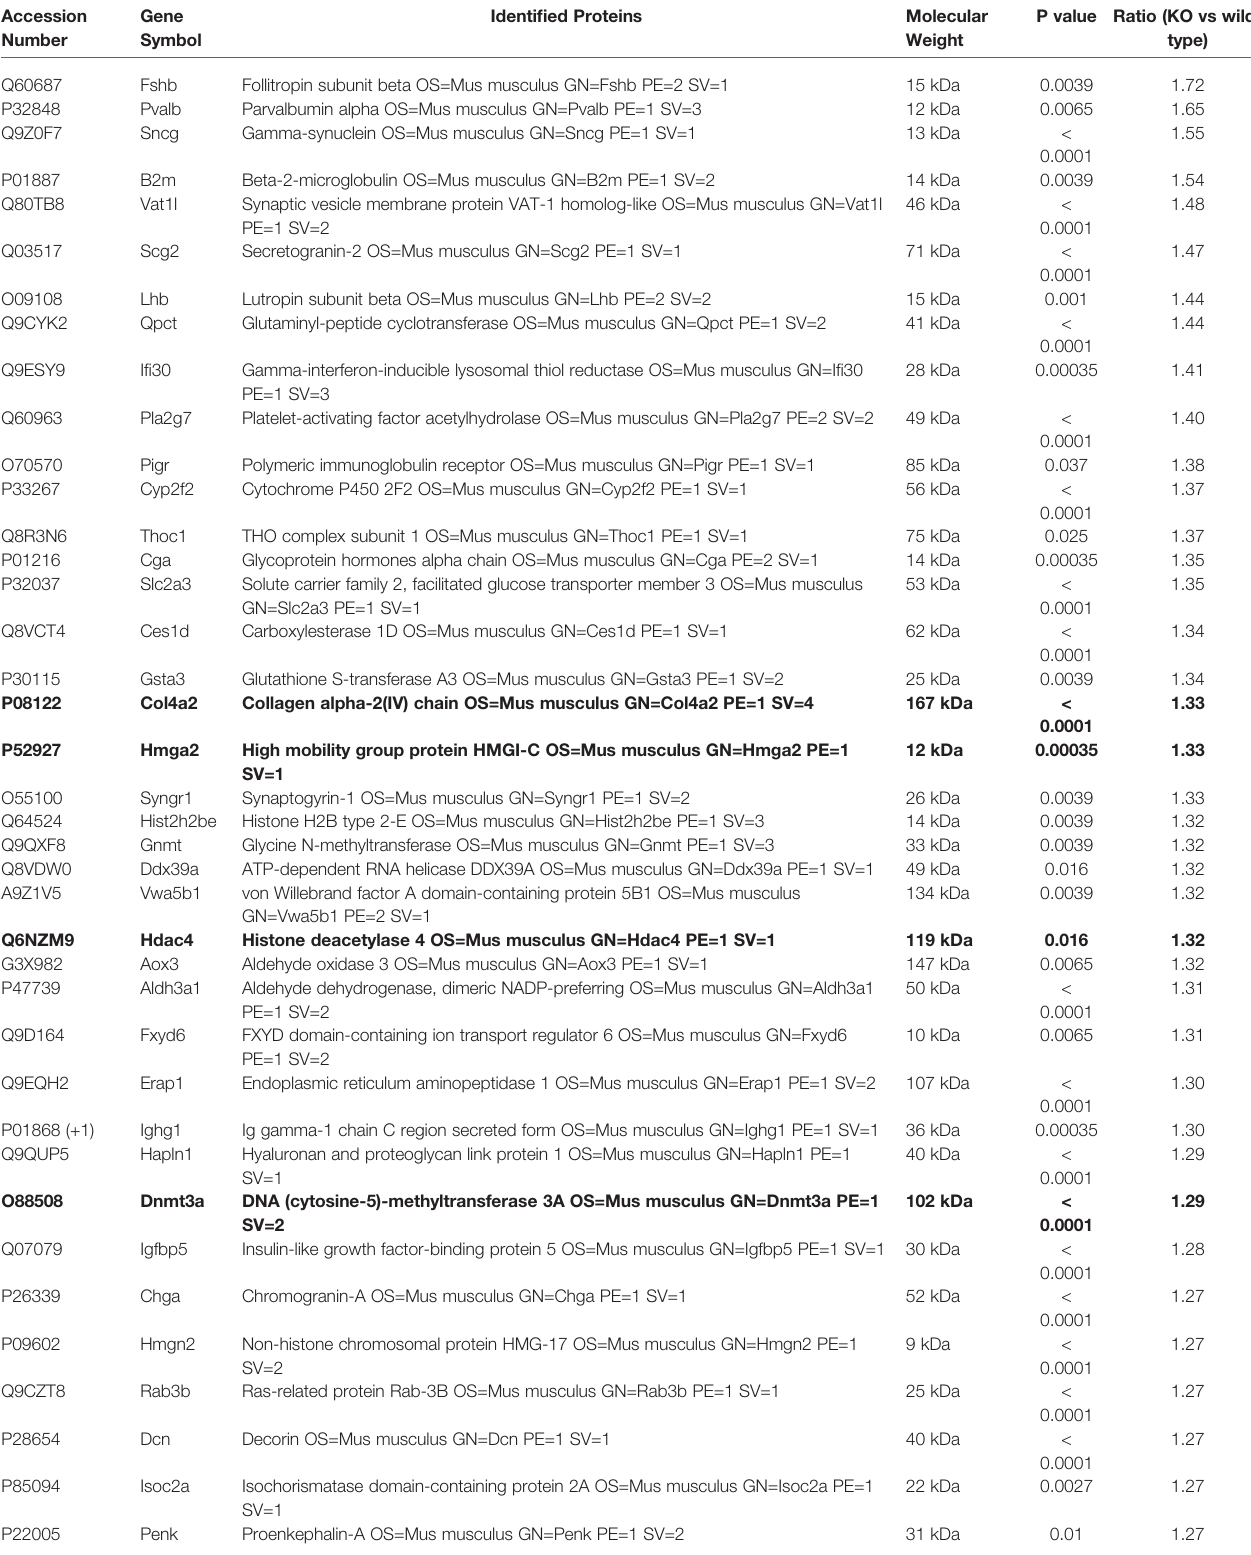
TABLE 2 | Differentially expressed proteins in pituitary involved in miR-29 regulation and protein transport ( p<0.05 and fold change ≥ 1.2 or ≤ 0.83 ). Accession Number